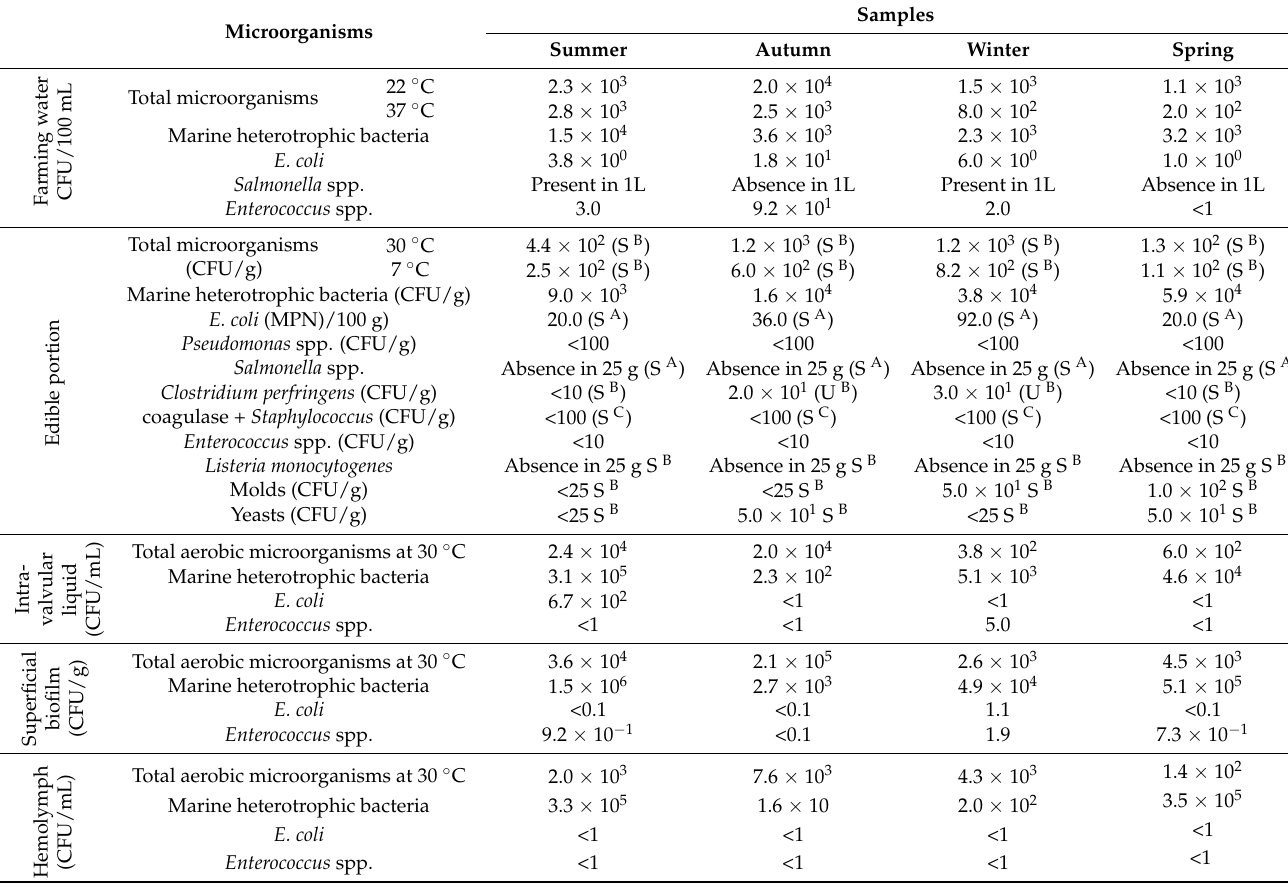
Table 2. Microbiological analysis of farming waters, edible portions (flesh, hemolymph, and intra- valvular liquid), superficial biofilm, intra-valvular liquid, and hemolymph during all seasons, using classic